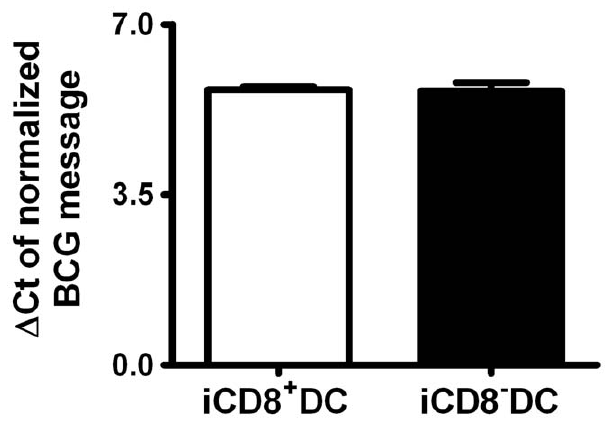
Figure 9. DC subsets from BCG-infected mice show similar BCG load. A real-time RT-PCR using the green fluorescent dye SYBR Green I was applied to determine the relative concentration of BCG mRNA in iCD8 + DC and iCD8 2 DC. The BCG mRNA in different DC subsets was amplified as described in Materials and Methods. The BCG mRNA level was normalized to GAPDH mRNA in different DC subsets demonstrated as D Ct . D Ct = Ct (BCG)– Ct (GAPDH), the threshold cycle of a BCG and the threshold cycle of the corresponding GAPDH in the same